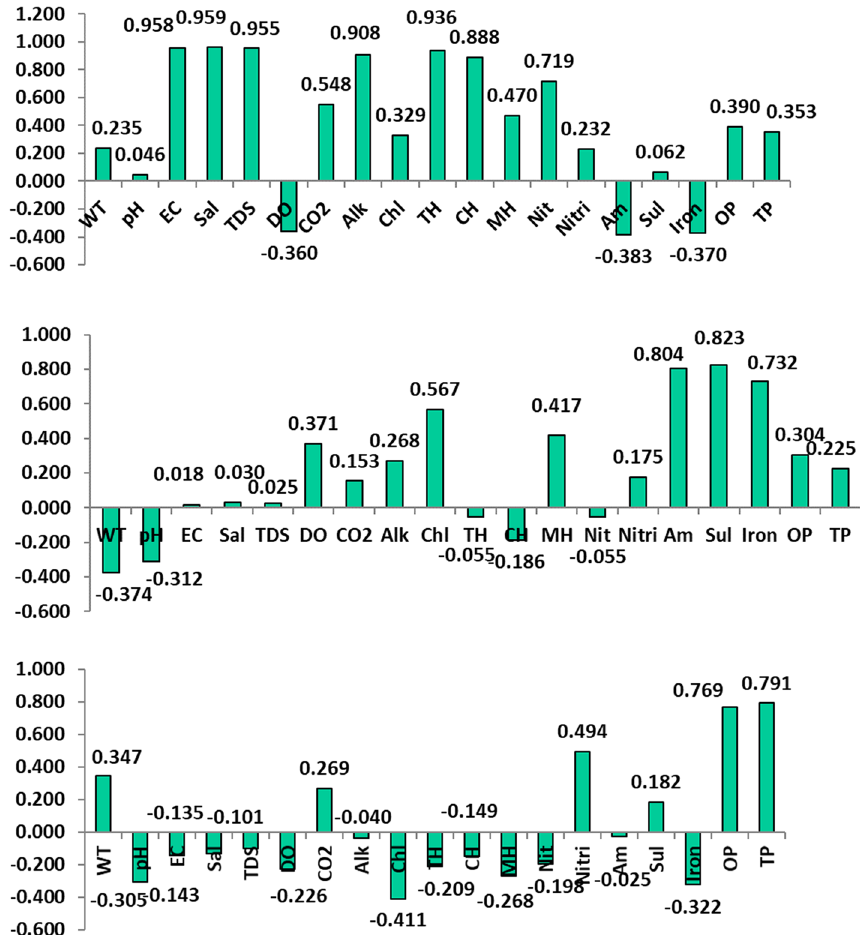
Fig. 7 Factor scores for the a factor 1 b factor 2 c factor 3 of hydro-chemical constituents in the spring water samples. Abbreviations of the water parameters are: Water tempera- ture (WT), pH, Electrical con- ductivity (EC), Salinity (Sal), Total dissolved solids (TDS), Dissolved oxygen (DO), Free carbon dioxide (CO 2 ), Total alkalinity (Alk), Chloride (Chl), Total hardness (TH), Calcium hardness (CH), Magnesium hardness (MH), Sulphate (Sul), Iron Nitrate (Nit), Nitrite (Nitri), Ammonia (Am), Ortho- phosphorus (OP), and Total phosphorus